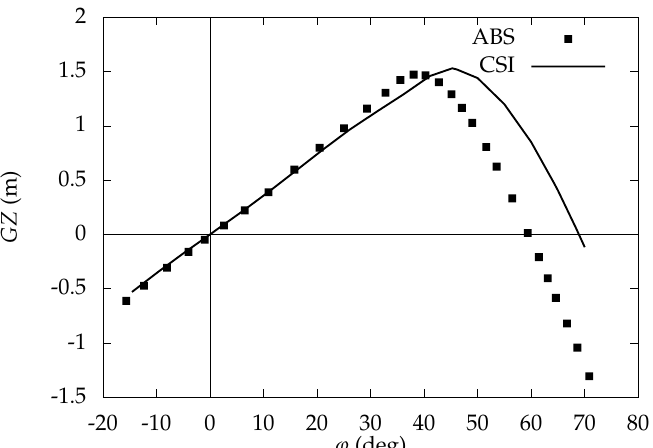
Figure 19. GZ curve for C11 container ship test case for the assessment of dead ship level